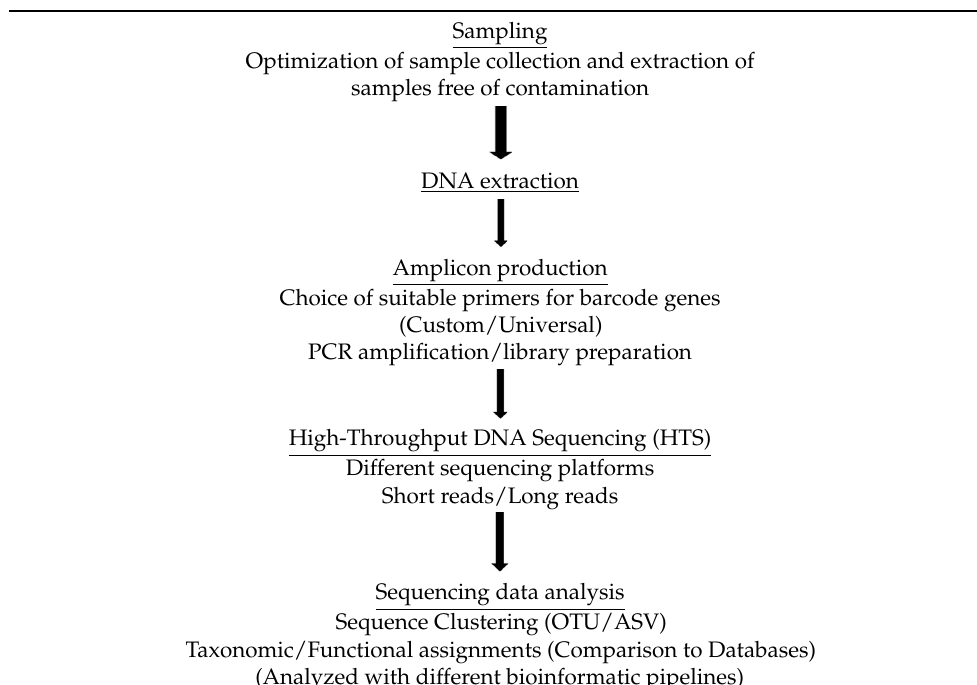
Table 1. Step procedures in metabarcoding approach (discussed in the text).